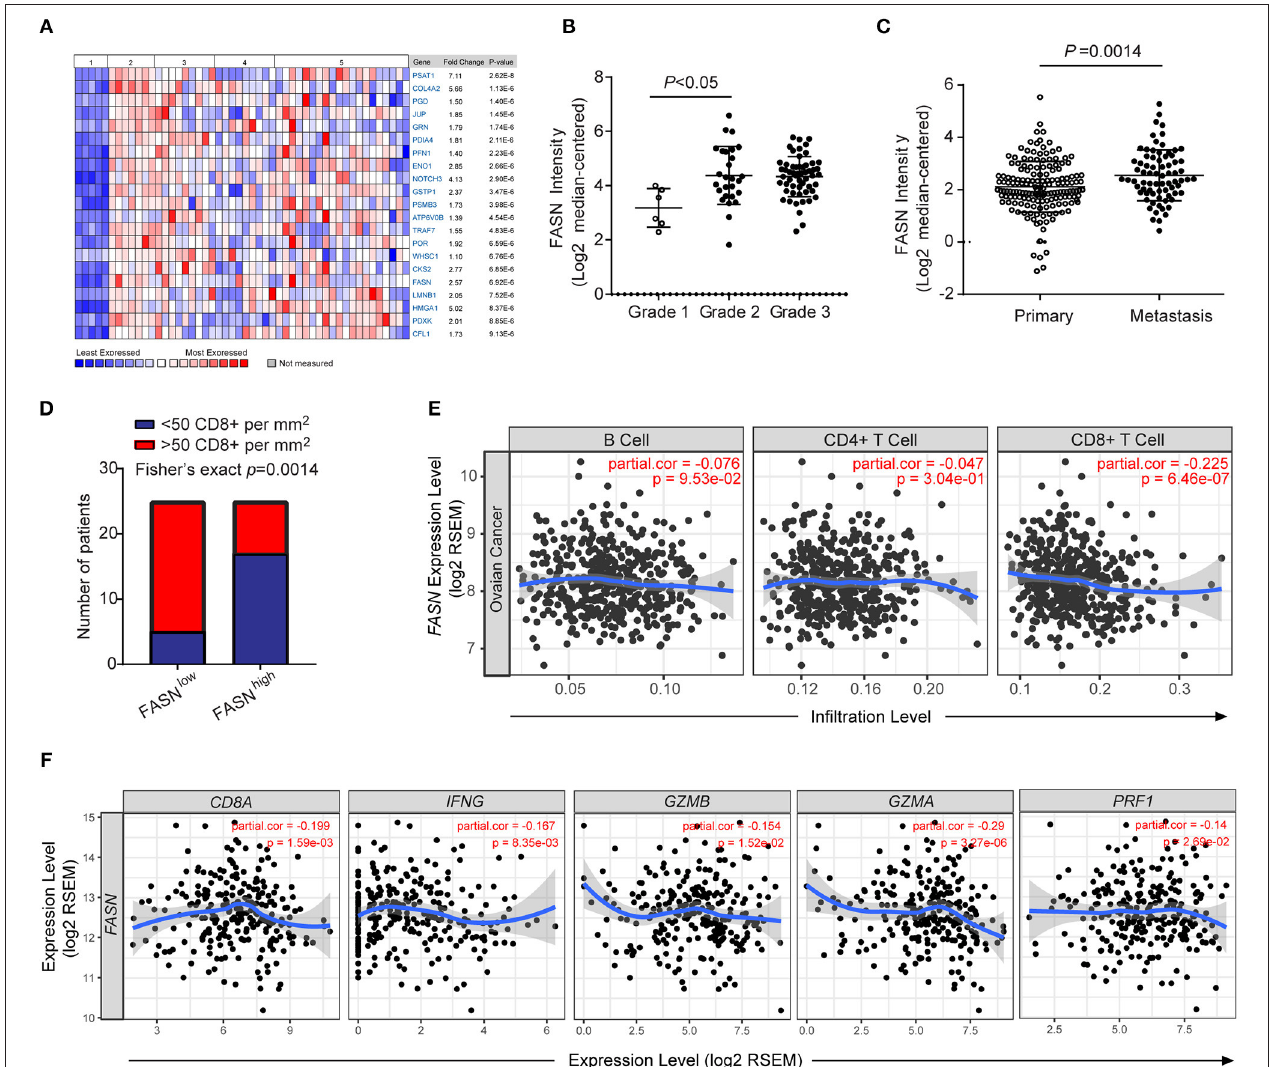
FIGURE 1 | FASN was upregulated in human ovarian cancer and negatively correlated anti-tumor functional T cell infiltration. (A) Heatmap depicted top genes list increased in different types of human ovarian cancer compared to the normal ovarian surface epithelium. 1. Ovarian Surface Epithelium ( n = 5); 2. Ovarian Clear Cell Adenocarcinoma ( n = 7); 3. Ovarian Endometrioid Adenocarcinoma ( n = 9); 4. Ovarian Mucinous Adenocarcinoma ( n = 9); 5. Ovarian Serous Adenocarcinoma ( n = 20). (B) FASN expression was upregulated in a higher grade of human ovarian cancer. (Grade 1, n = 6; grade 2, n = 27; grade 3, n = 58). (C) The expression of FASN was increased in OvCa patients with metastasis (Primary patients, n = 166, metastatic patients, n = 66). (D) Correlation between the expression intensity of FASN and distribution of CD8 + T cells in human ovarian cancer biopsies. Fisher’s exact test with n = 50 (FASN low, n = 25; FASN high, n = 25). (E) The correlation of FASN mRNA expression with tumor-infiltrating B cells, CD4 + T cells and CD8 + T cells in human ovarian cancer based on TIMER analysis from TCGA datasets. The scatterplots showed the purity-corrected partial Spearman’s correlation and statistical significance. (F) The correlation of FASN mRNA expression with gene signature of CD8 + T cells ( CD8A, IFNG, GZMB, GZMA, and PRF1 ) in human ovarian cancer based on TIMER analysis. The scatterplots showed the purity-corrected partial Spearman’s correlation and statistical significance.